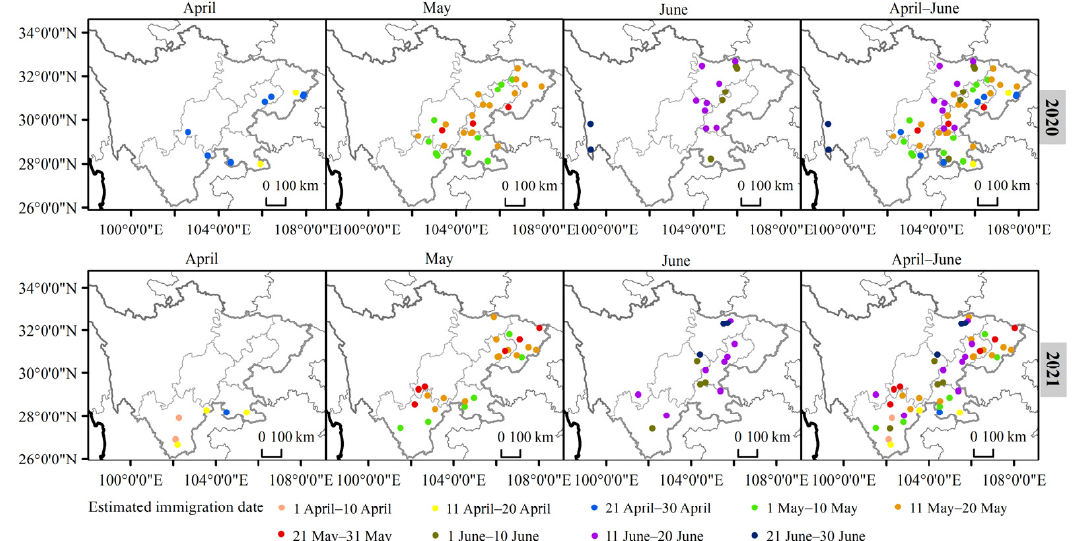
Figure 2. FAW migration dynamics in the Sichuan Province from April to June 2020 and 2021. The colored dots represent the sites where the migration of FAWs have been detected in different time periods. The year and time periods of migration are labeled on the top/right of each panel.